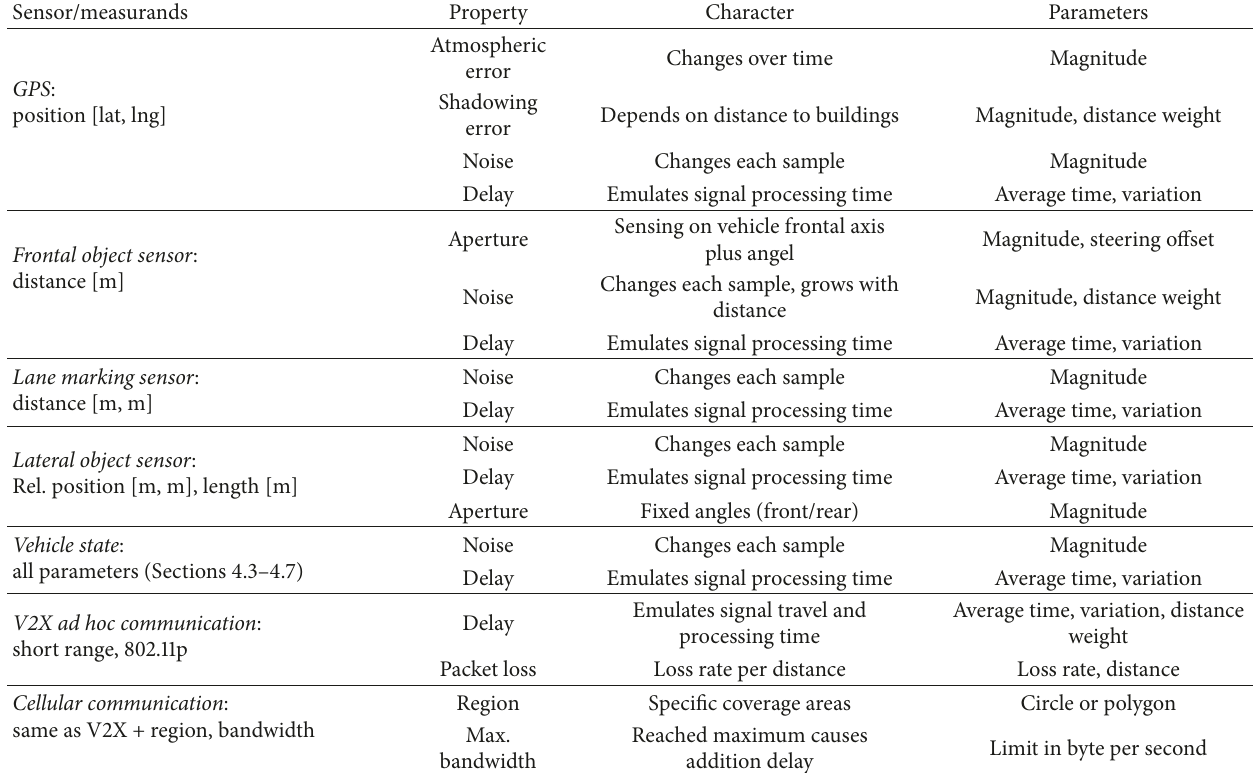
Table 3: Sensor and communication